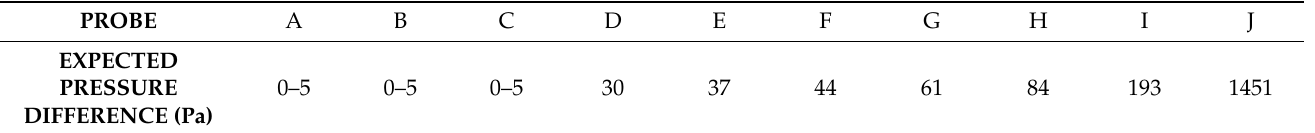
Table 3. The expected pressure difference in the pressure